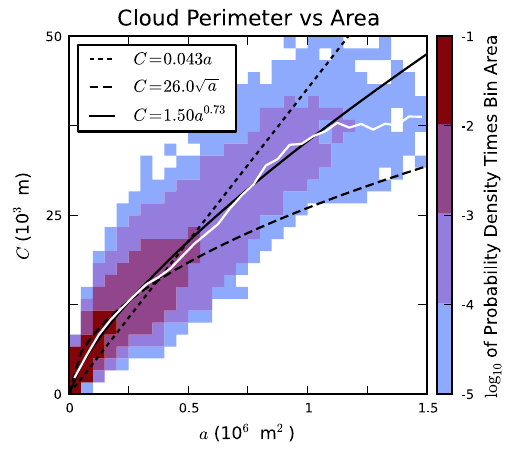
Fig. 9. Joint probability density function multiplied by bin area of cloud core perimeter C versus cloud core cross-sectional area a ( P(a,C)1a1C ) for individual clouds in the combined BOMEX and ARM LES output. PDF is plotted using a logarithmic scale. White line shows the mean perimeter of clouds as a function of cross-sectional area. Black dotted, dashed, and solid lines show best-fit lines for linear, square root, and an arbitrary power law re- lationships, respectively.